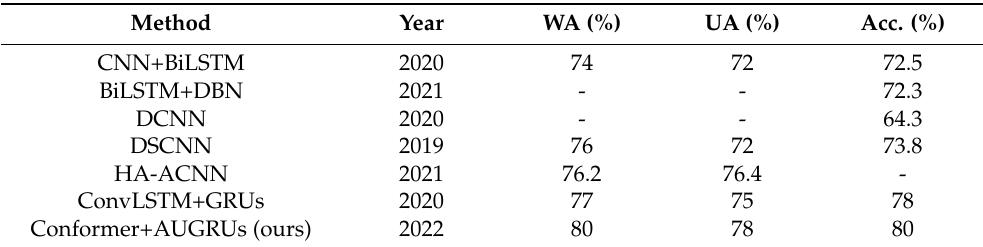
Table 3. Accuracy summary obtained by various models using the IEMOCAP database. WA is the weighted accuracy and UA is the unweighted